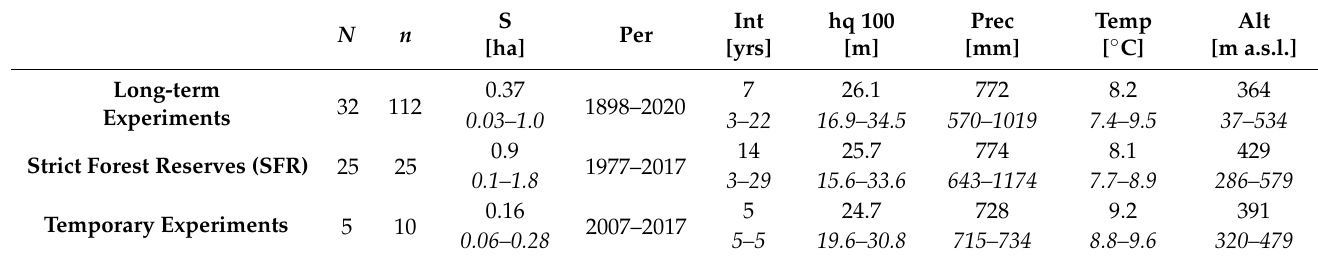
Table 1. Main characteristics of the investigated research plots; N —number of experiments/research sites; n —number of research plots/stands; S—plot size [ha]; Per—observation period [calendar year]; Int—inventory intervals [yrs]; hq 100—quadratic mean height at the age of 100 years;